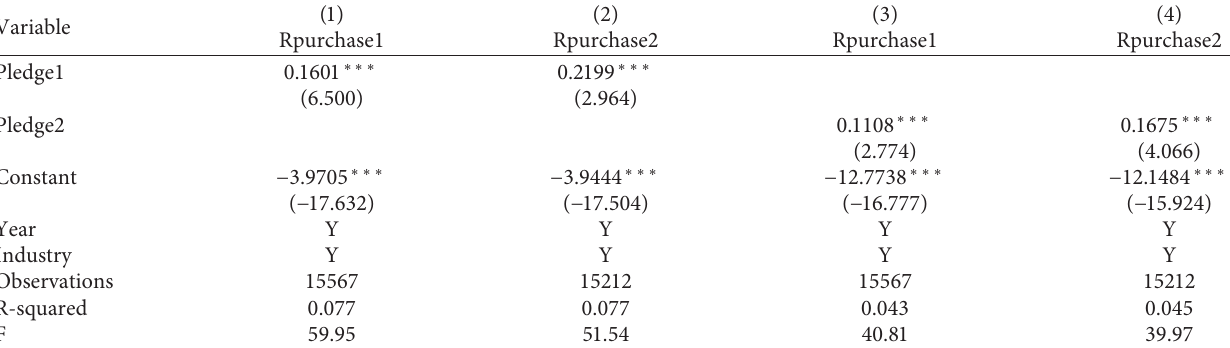
Table 5: Regression results of propensity score matching.